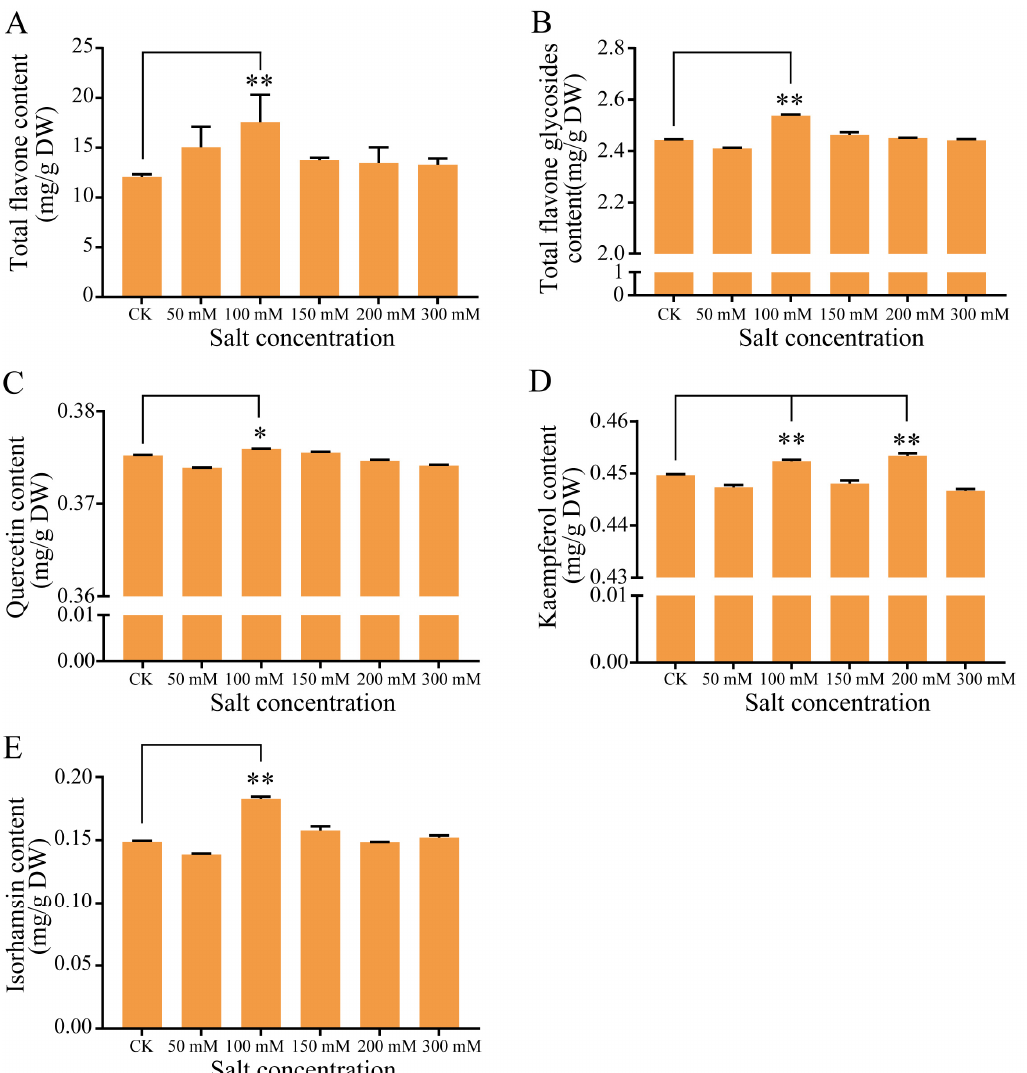
Figure 3. Total flavonoid and flavonol glycoside content in G. biloba . The contents of the ( A ) total flavones, ( B ) total flavone glycosides, ( C ) quercetin, ( D ) kaempferol, and ( E ) isorhamnetin were determined under 0, 50, 100, 150, 200, and 300 mmol / L NaCl conditions. The leaves were harvested after 14 days. * p < 0.05; ** p < 0.01. The vertical bars indicate SD ( n = 9).